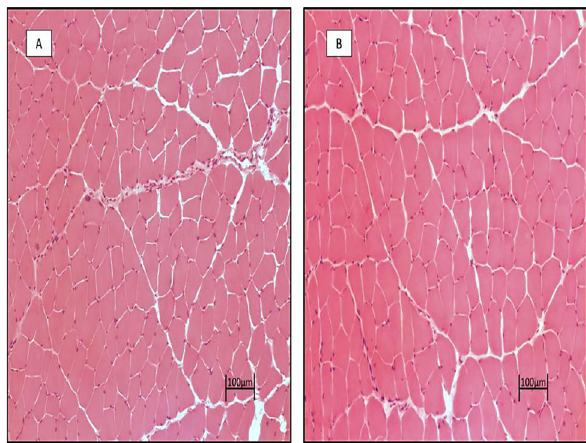
Figure 3 - Muscle fibers from bcontrol and HIIT training after eight weeks in rats. (A): Control Group; (B): HIIT training Group. Hematox- ylin-eosin (HE) staining.